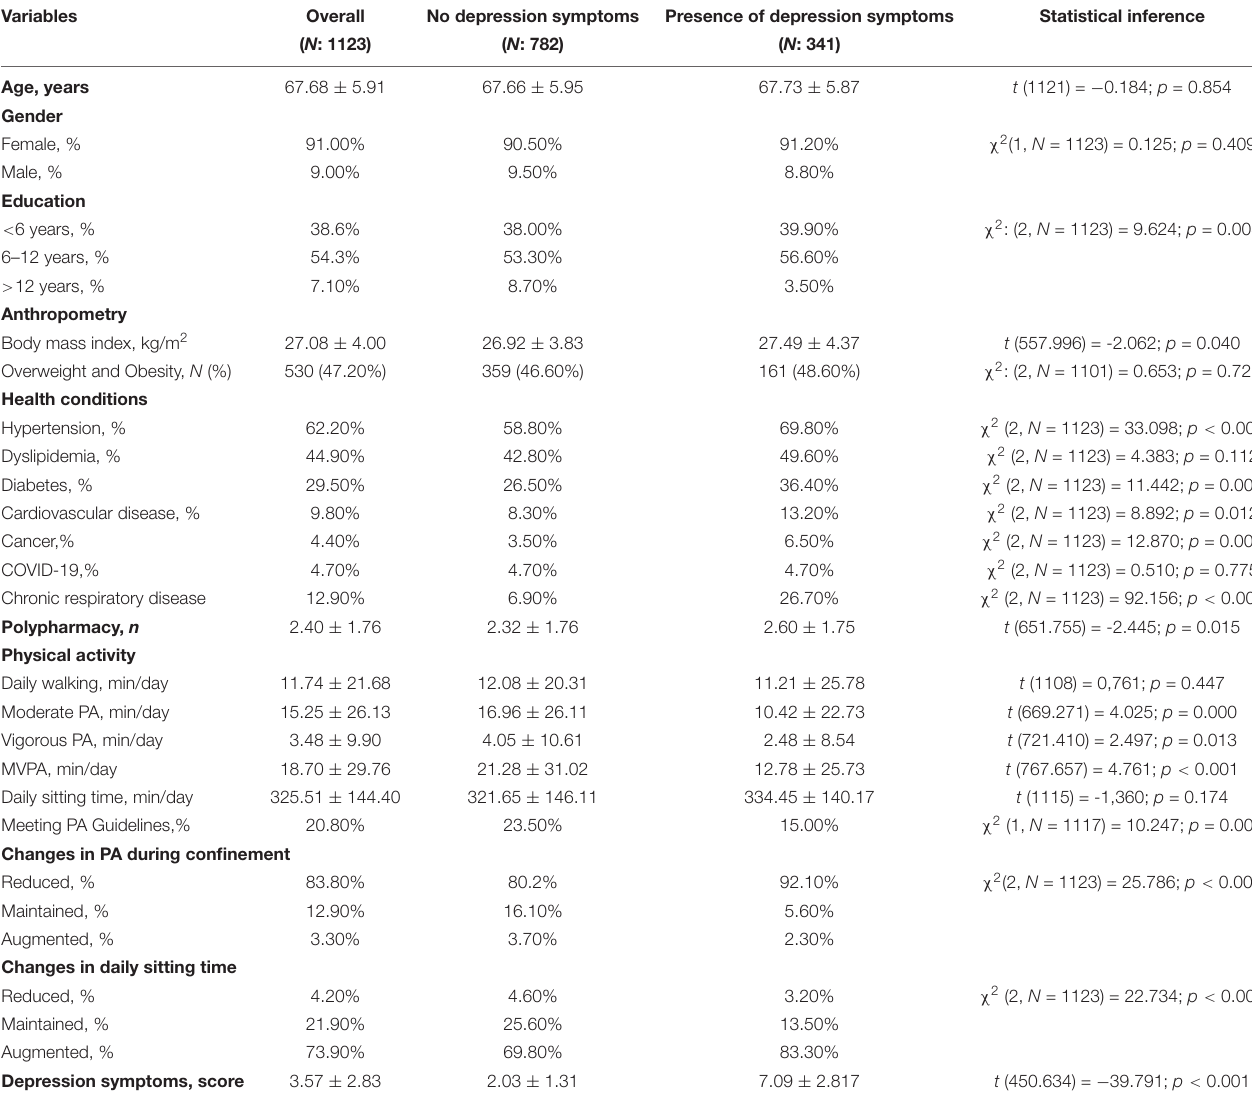
TABLE 1 | Descriptive and between-groups